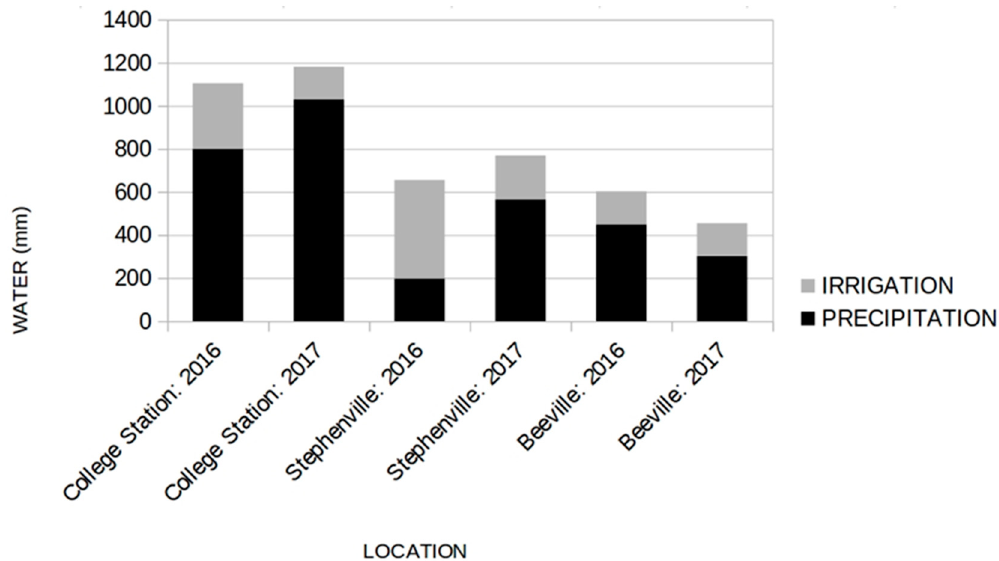
Figure 1. Total cumulative irrigation and precipitation inputs (mm) at trial sites in College Station, Stephenville, and Beeville, TX in 2016 and 2017.